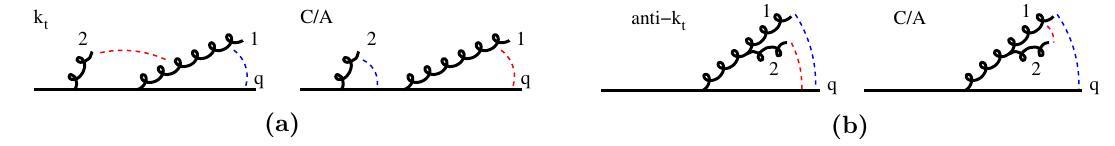
Figure 4. Con(cid:12)gurations that lead to terms (cid:11) 2 L 2 for the Lund plane density for algorithms other s than C/A, showing with a red (blue) dashed line the clustering that occurs (cid:12)rst (second). (a) For the k t -declustered Lund plane: emission 2 clusters with emission 1 rather than with the quark and so fails to appear as part of the primary Lund plane. (b) For the anti- k t -declustered Lund plane: emission 2 gets declustered as a primary emission, even though physically it belongs to the secondary Lund plane associated with emission 1, resulting in a spurious enhancement of the primary Lund plane